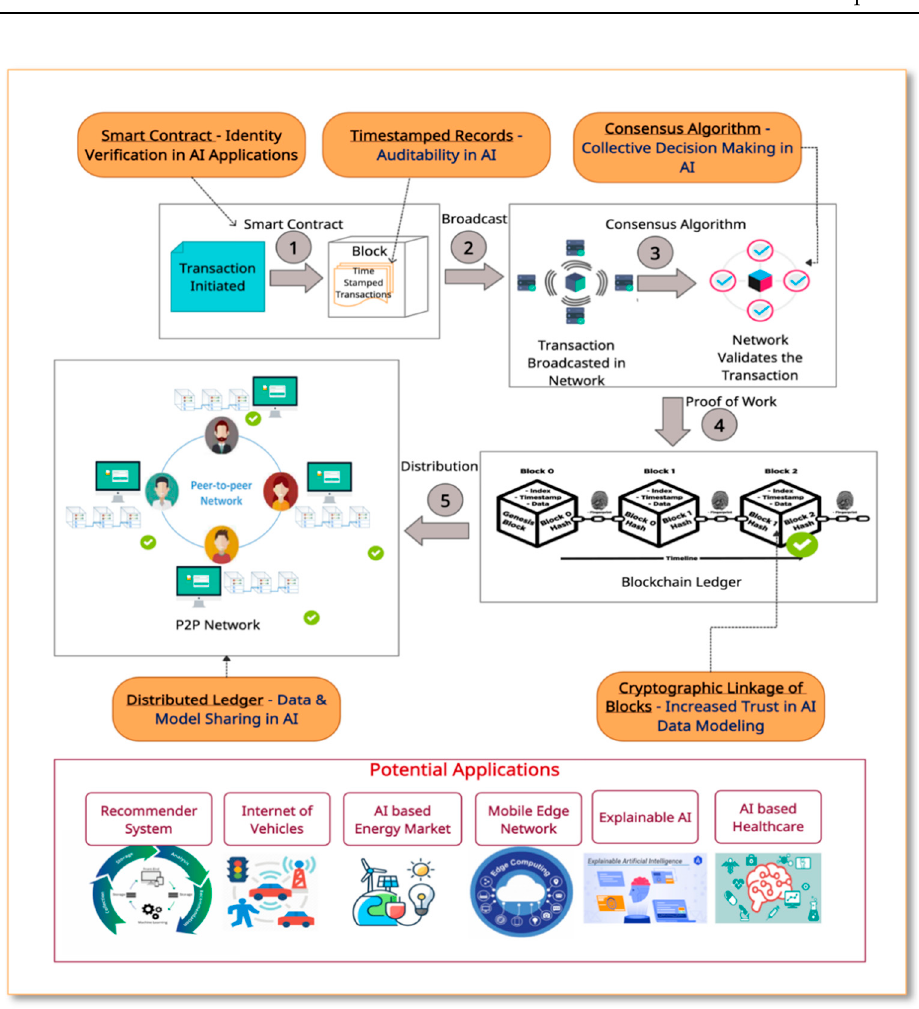
Figure 20. Step by step working of Blockchain reflecting its benefits in AI